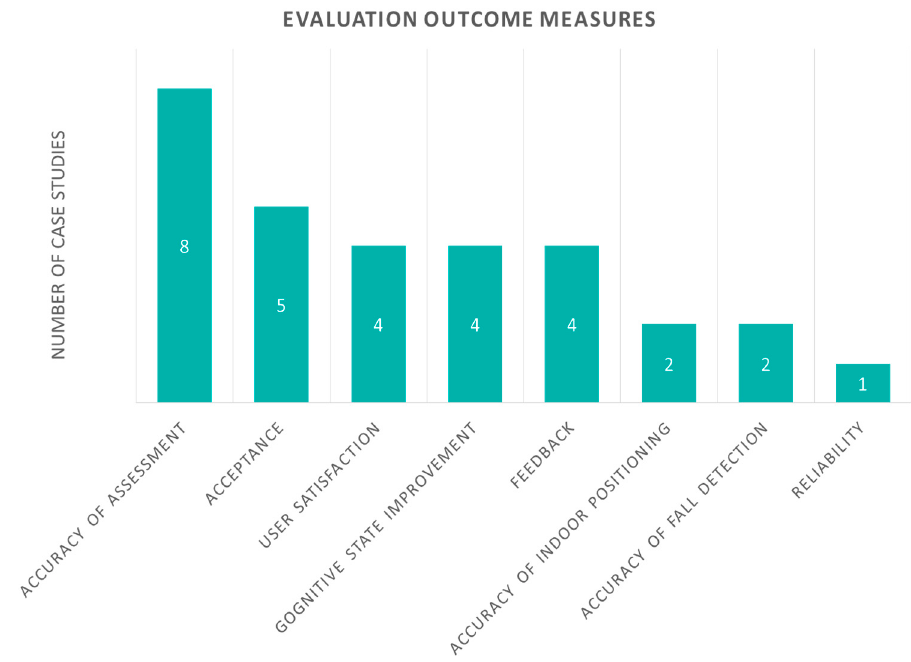
Figure 11. Case studies with evaluation according to their outcome measures.